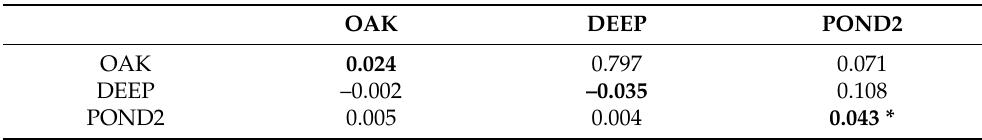
Table 3. Pairwise population differentiation using G” ST (below the diagonal) and p values (above the diagonal) as well as inbreeding coefficient G IS (along the diagonal and bolded) for each of the three ponds of Ambystoma opacum in the Maple Flats Sinkhole complex. An asterisk (*) indicates significance. OAK DEEP POND2 OAK 0.024 0.797 0.071 DEEP –0.002 –0.035 0.108 POND2 0.005 0.004 0.043